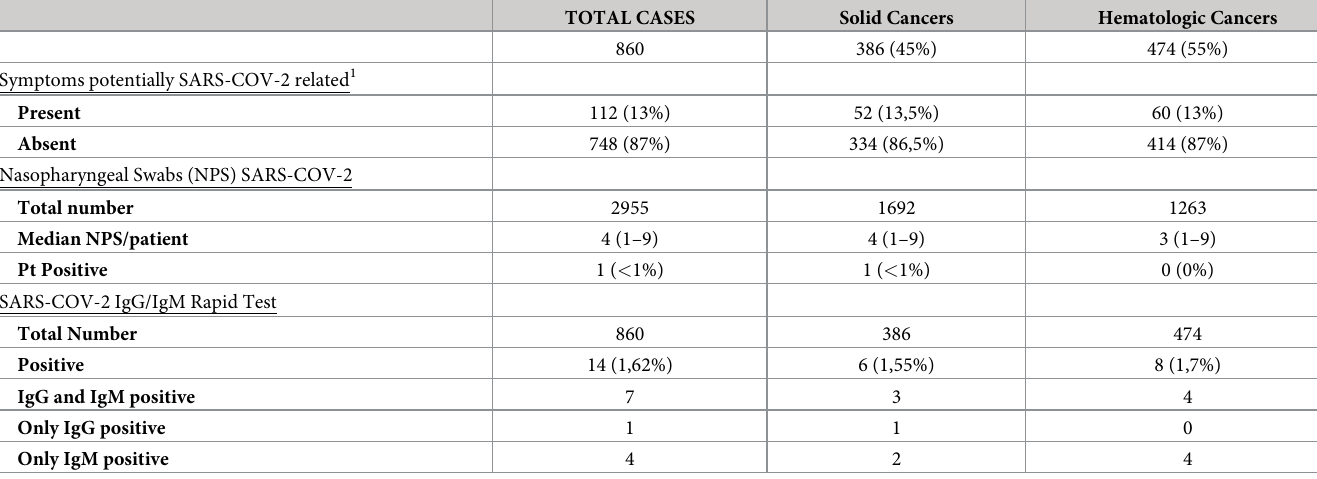
Table 2. Results of the combined screening